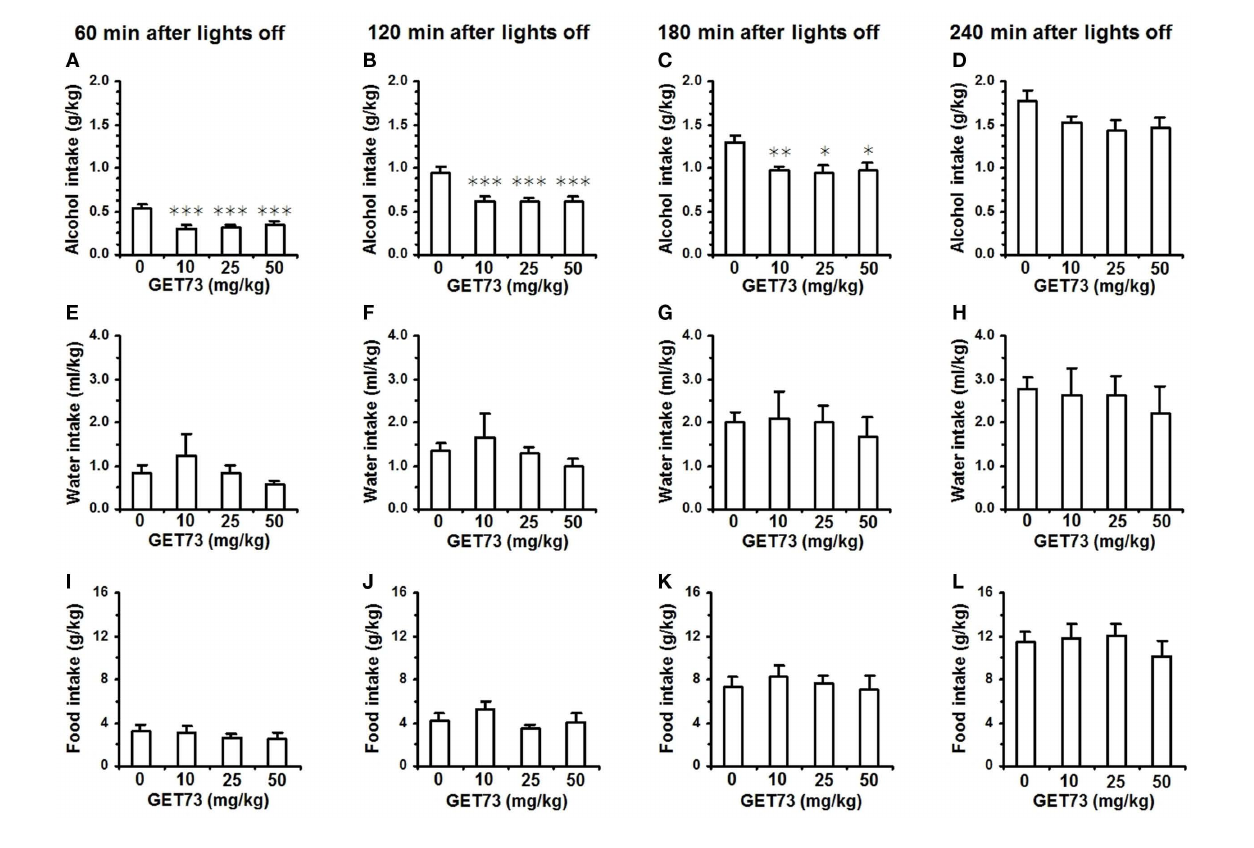
access for 24h/day. GET73 was administered 30min before lights off. Alcohol, water, and food intake was recorded 60, 120, 180, and 240min after lights off. Each bar is the mean ± SEM of n = 10 rats. * P < 0.05, ** P < 0.01, and *** P < 0.005 with respect to 0-mg/kg GET73-treated rat group (Newman–Keuls